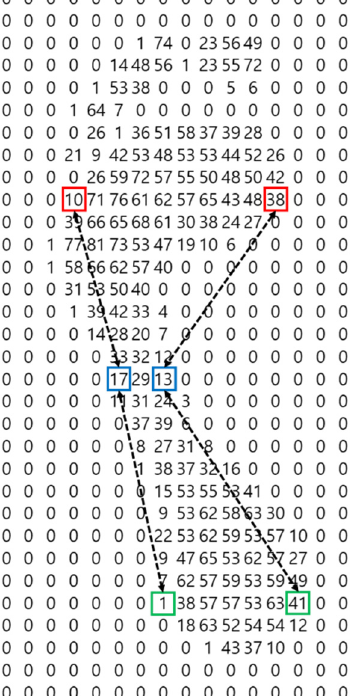
Figure 12. Deviation between left and right sides of a footfall.